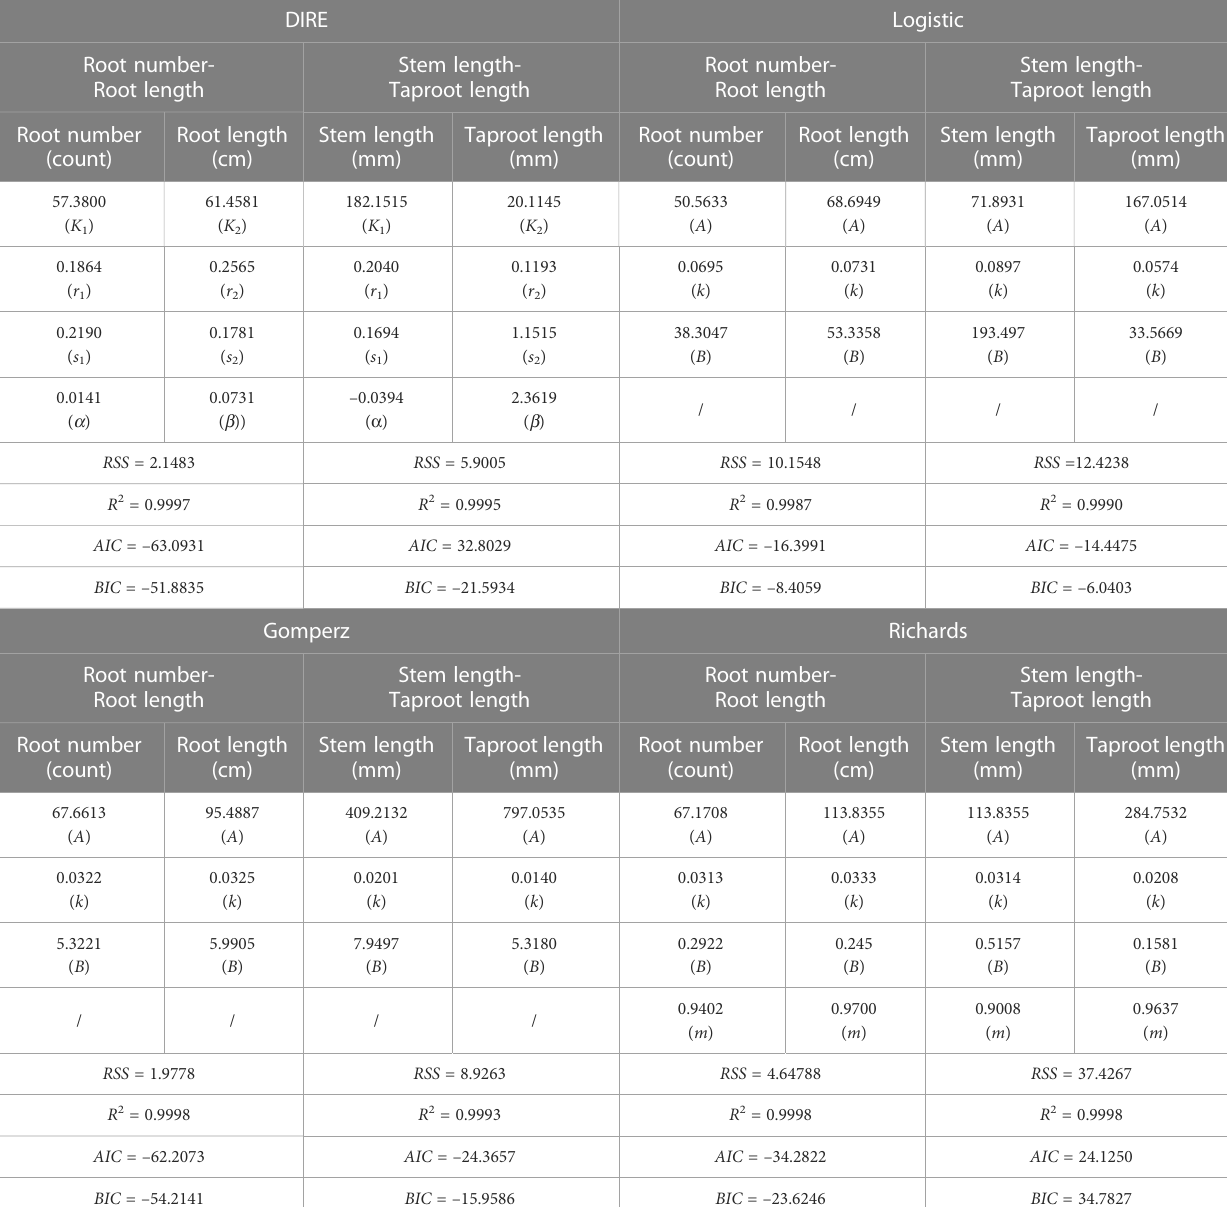
TABLE 1 The estimated parameters and the evaluation information of DIRE. DIRE